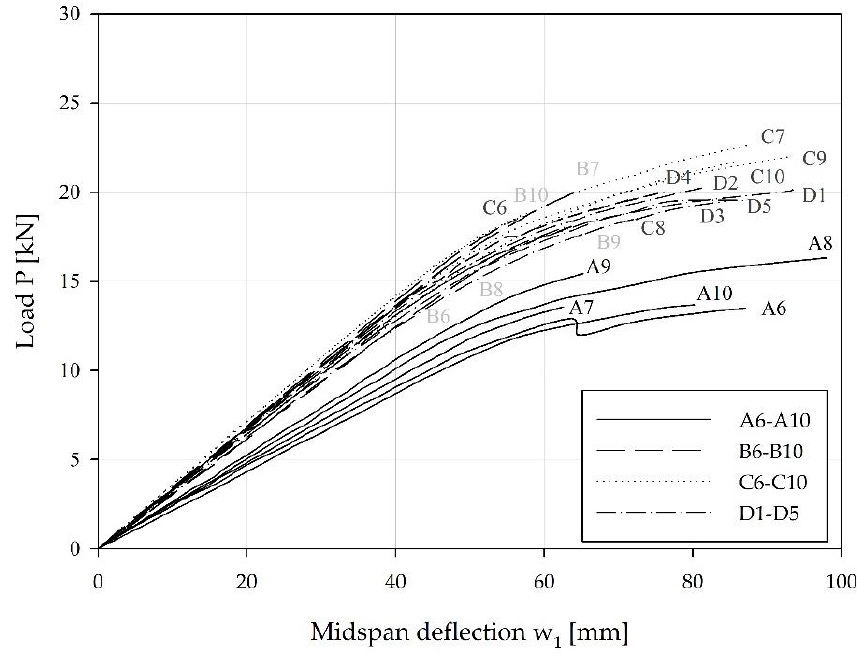
Figure 13. Load-midspan deflection relationship of Series Figure 13. Load‐midspan deflection relationship of Series S2. Figure 13. Load‐midspan deflection relationship of Series S2.